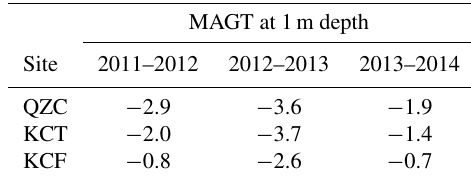
Table 4. The MAGT at 1m depth for the three sites, installed in 2011, from which we have 3 years of